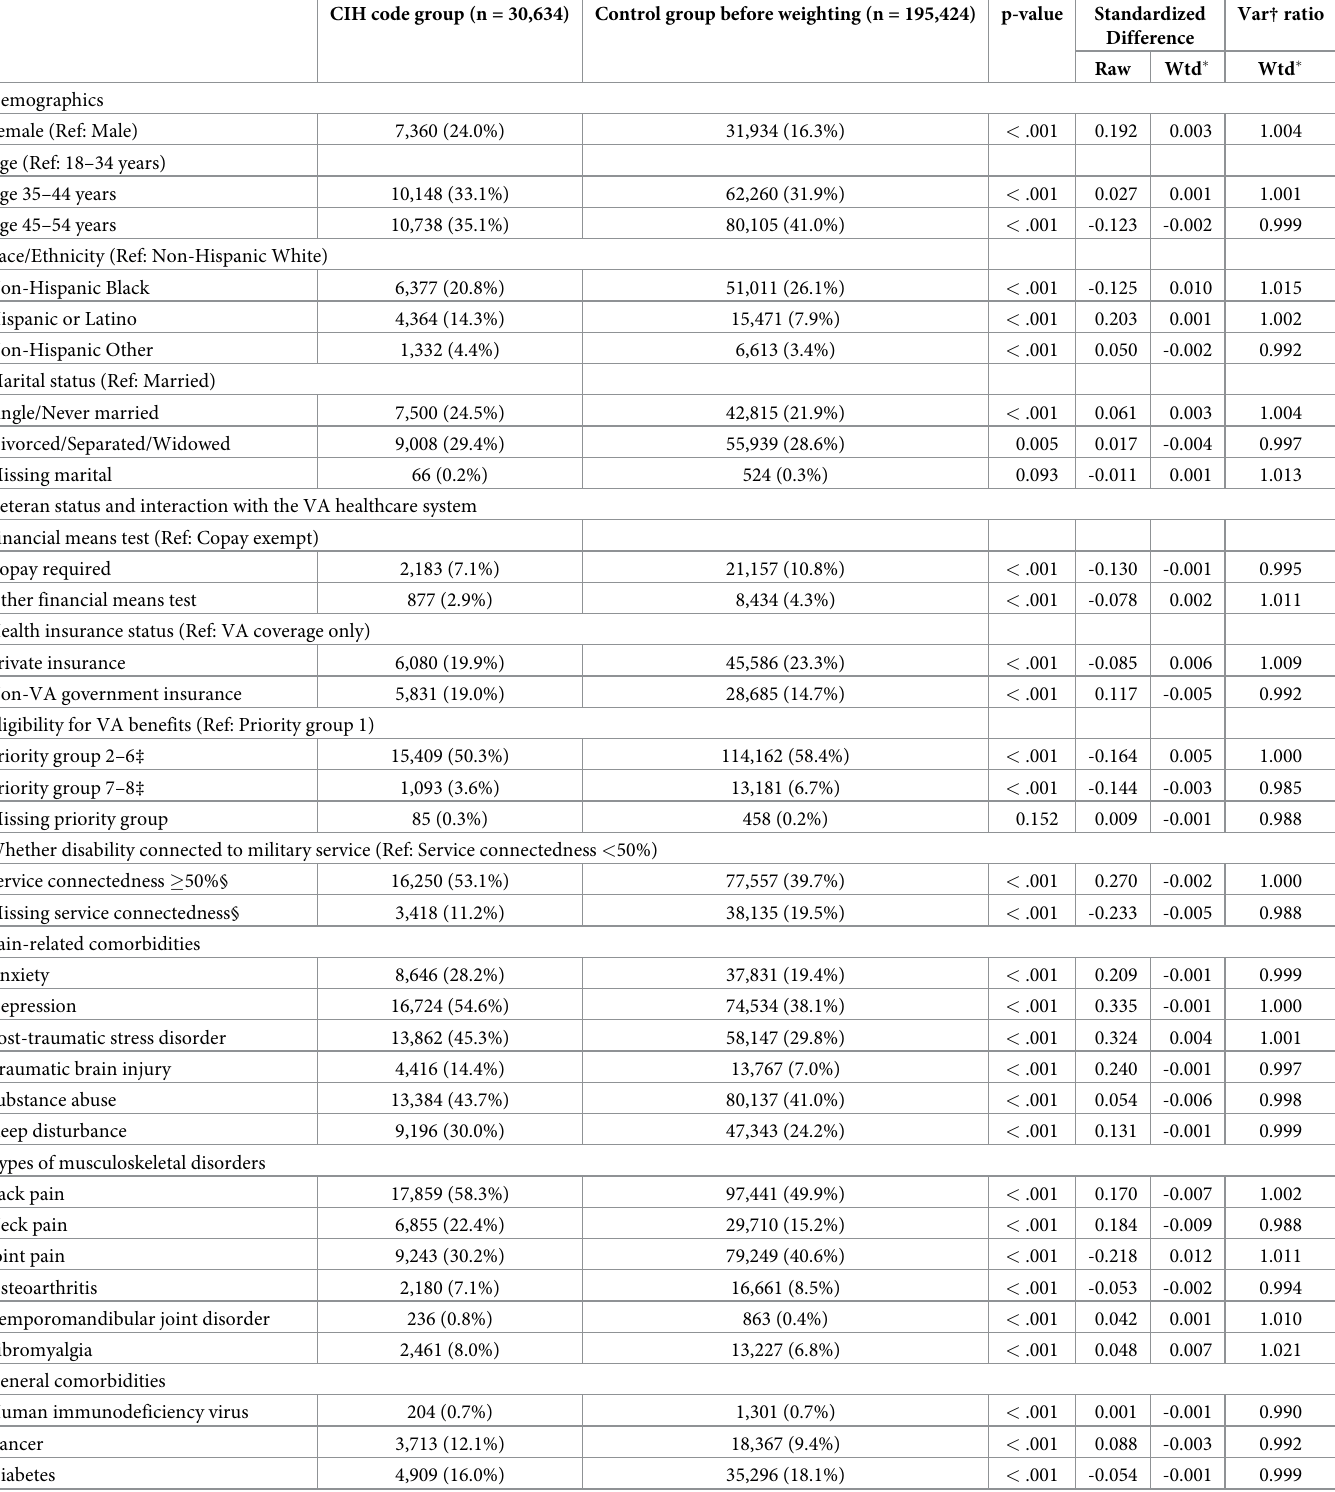
Table 1. Covariates available for analysis, their values in each group, and the impact of propensity score weighting on the differences seen in means and